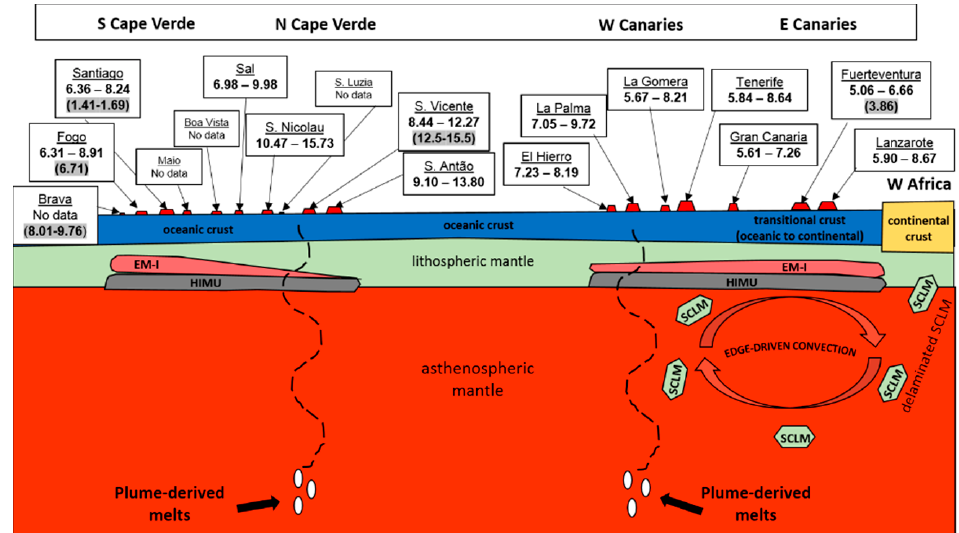
Figure 9. Hypothetical schematic profile view of the upper mantle/crust under the Cape Verde and Canary Archipelago (not to scale) with the involvement of the proposed mantle components and the mechanism of physical detachment of the sub-continental lithospheric mantle (SCLM) caused by edge-driven convection during breakup of the Pangea Supercontinent and incorporated into the oceanic lithospheric mantle beneath at least some Canary Islands [20,24,112,113]. Also shown is a geographical distribution of the R/Ra range for each island of olivine (clinopyroxene in the case of Fuerteventura) from mafic/ultramafic rocks, and calcite from carbonatites (values in grey field). Data for the Canary Islands are from [99] for Gran Canaria, Tenerife and La Gomera; [111] for La Palma and El Hierro; [114] for Lanzarote. Data for the Cape Verde Archipelago are from [115] for S. Antão; [100] for Fogo, Santiago, S. Vicente, S. Nicolau and Sal; [23] for Fogo, Santiago, S. Vicente and Brava (on carbonatites).